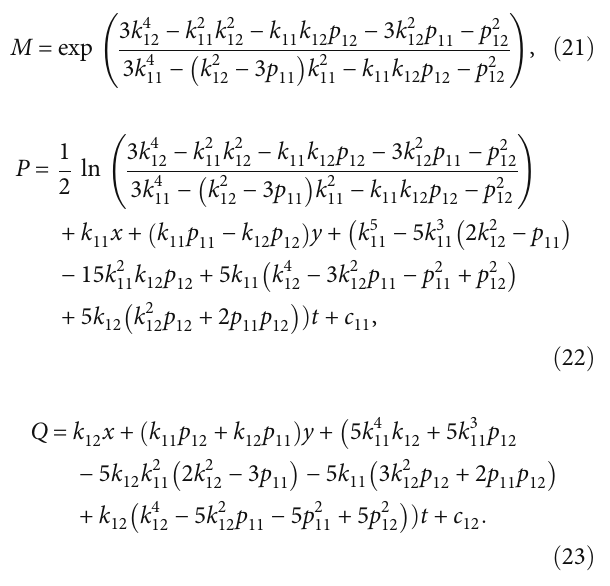
= 0, k = 2, p = 1, p = 2, and c 11 12 11 12